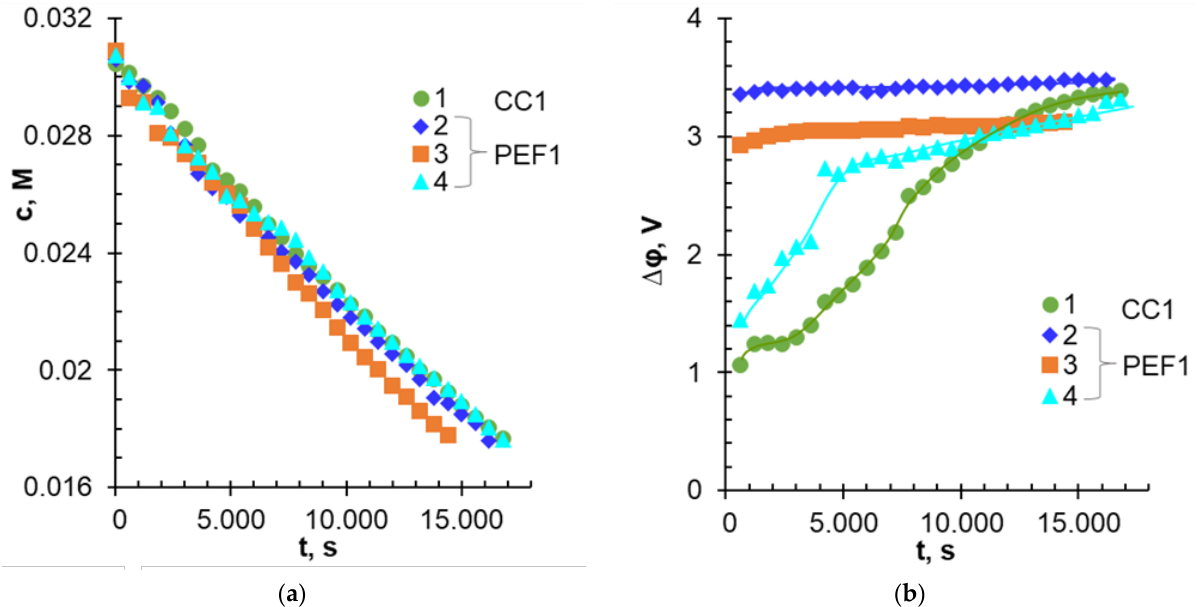
in Figure 3. These data were obtained at average current densities equal to 3 mA cm − 2 . Figure 4 shows the degree of P V removal from the diluate vs. the energy consumption for average current densities of 3.0 and 3 mA cm − 2 . Table 4 summarizes the characteristics of the ED process at the degree of removal of 40% ( γ P V = 40%).